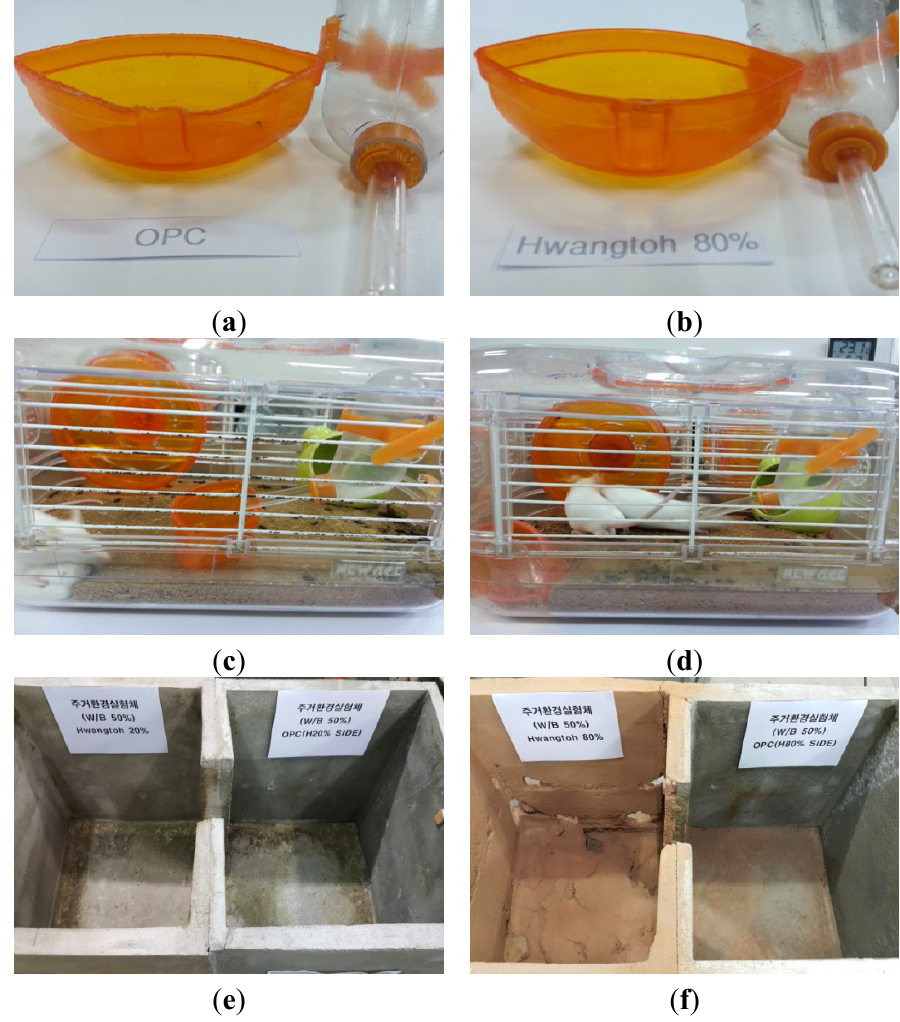
Figure 17. Damages caused by aggression. ( a ) Feeding and watering containers for OPC cage; ( b ) Feeding and watering containers for H80 cage; ( c ) Protection bars for OPC floor cages; ( d ) Protection bars for H20 floor cage; ( e ) Damaged lining of H20 residence cage, and ( f ) Damaged lining of H80 residence cage.